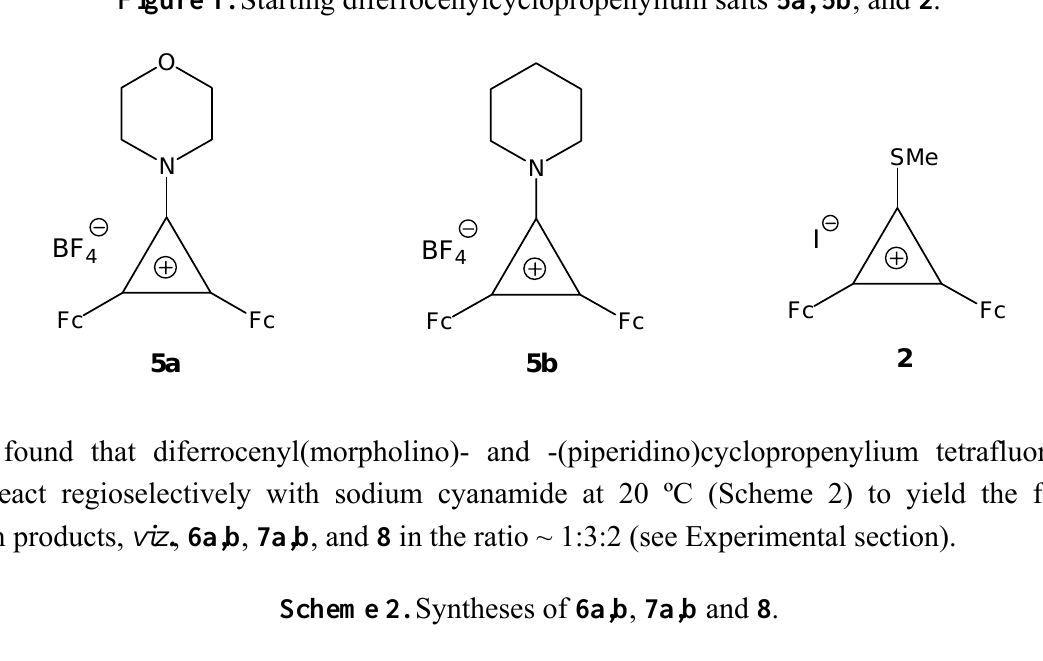
Figure 1. Starting diferrocenylcyclopropenylium salts 5a, 5b , and 2